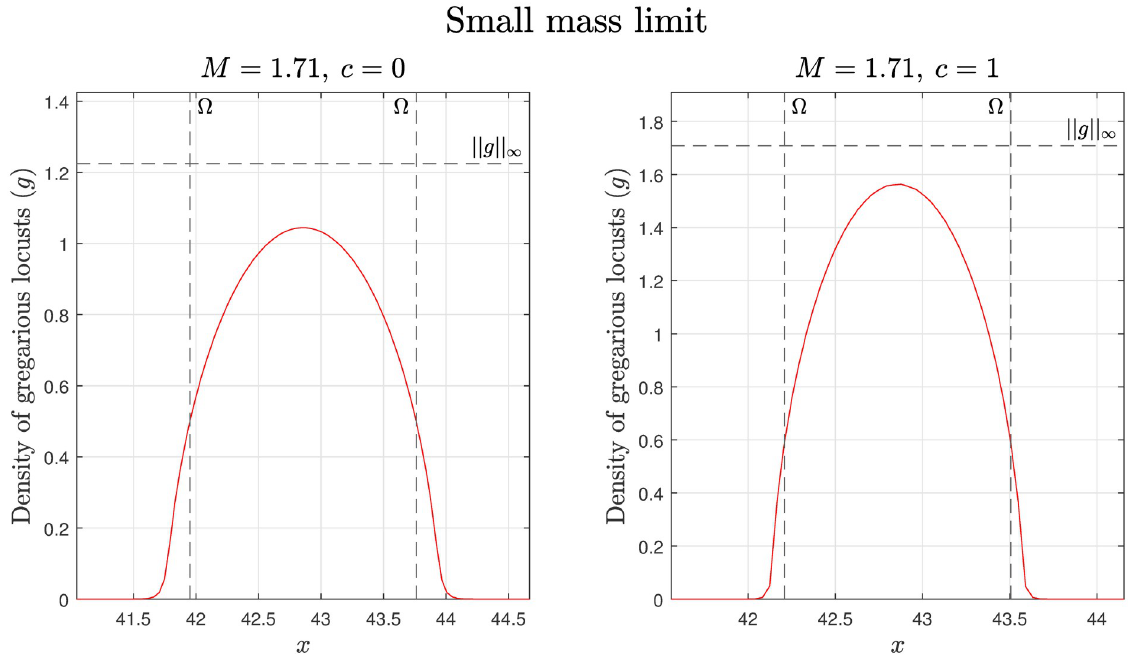
Fig 2. Small mass limit with estimates for the max value and support. The estimates of the max value and support are labelled || g || 1 and O respectively, with simulation results given by the red lines. For both the simulation and calculations D = 0.01, γ = 60, R g = 0.25, r g = 0.5, A g = 1, and c = 0 and 1.